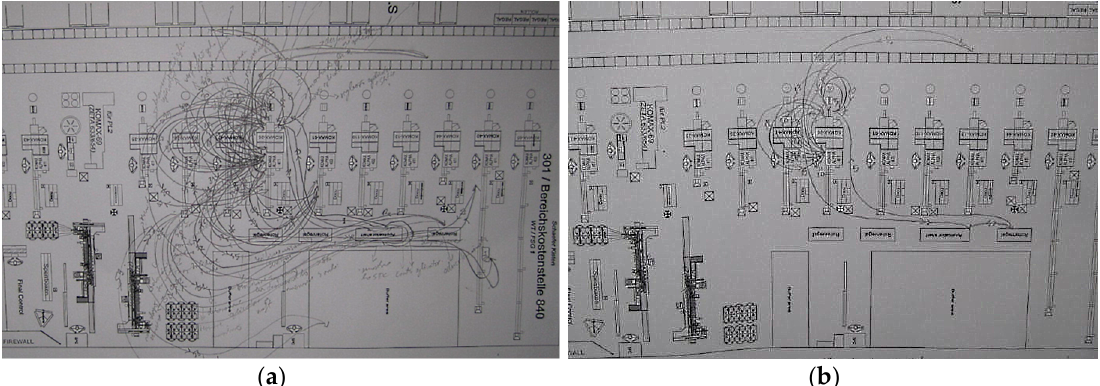
Figure 4. Spaghetti Diagram: ( a ) Spaghetti Diagram in the initial stage; ( b ) Spaghetti Diagram in the final stage.